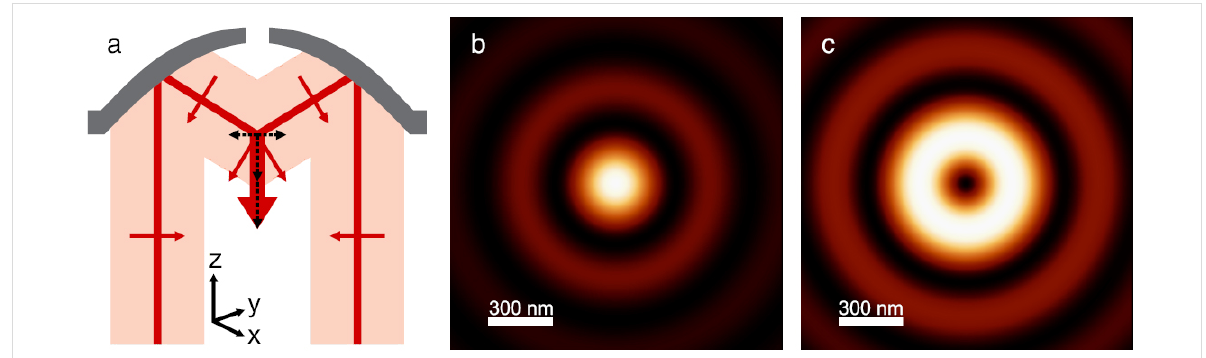
Figure 1: Focusing higher order laser modes with a parabolic mirror. (a) A sketch illustrating how a radial mode yields a strong field distribution in z-direction (optical axis of the microscope) in the focus of a parabolic mirror. The small red arrows depict the direction of the electric field; the dashed black arrows show their vector components. In the focus, the E-field components in x and y cancel each other out while the components in z sum up: large red arrow. (b) and (c): Calculation of the free-space field distribution (x,y plane-section) of higher order laser modes focused by a parabolic mirror; laser wavelength λ = 632.8 nm. (b) Focus of the radial donut mode. Only | E z | 2 , i.e., the electric field intensity normal to the sample surface is depicted; the components parallel to the sample surface are considerably weaker. (c) Focus of the azimuthal donut mode. The total intensity is depicted and corresponds to that of the field in x and y since E z is zero. The field polarisation is azimuthal within the bright focal